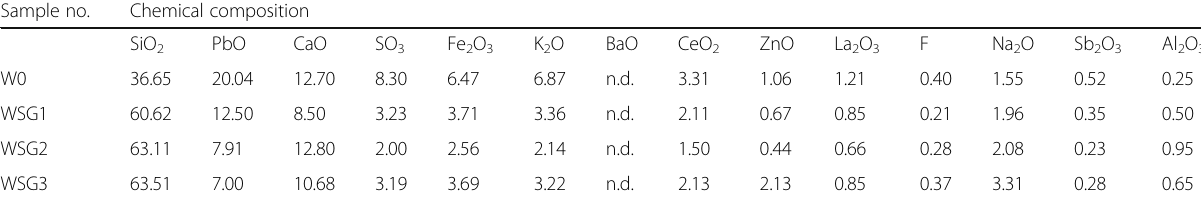
Table 3 Chemical analysis of the samples after sintering at 900 °C/2 h Sample